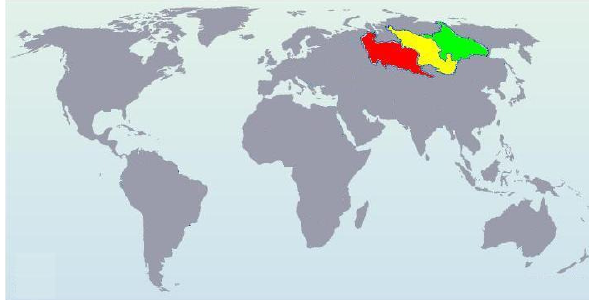
Fig. 4. Siberian river basins used in the investigation (UNEP/GRID- Arendal, 2002). In red is the Ob, in yellow is the Yenisei, and in Figure 4. Siberian river basins used in the investigation (UNEP/GRID-Arendal, 2002). In red 3 green is the Lena. This author has edited the colours and removed is the Ob, in yellow is the Yenisei and in green is the Lena. This author has edited the colours 4 other basins that were in the and removed other basins that were in the image. 5